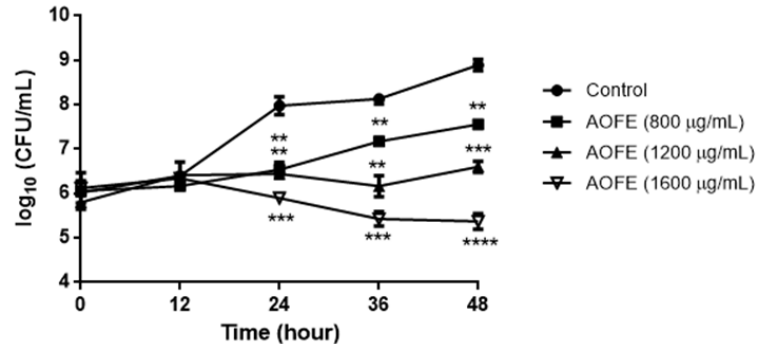
Figure 2. Effect of AOFE on Mp growth. Mp was cultured without (control) or with different concentrations of AOFE. The cultures were sampled at 0, 12, 24, 36, and 48 h and quantified for the titers of Mp by qPCR. The results shown are representative of two independent experiments with similar results ( n = 3). ** p < 0.01, *** p < 0.001, **** p < 0.0001 versus the control.